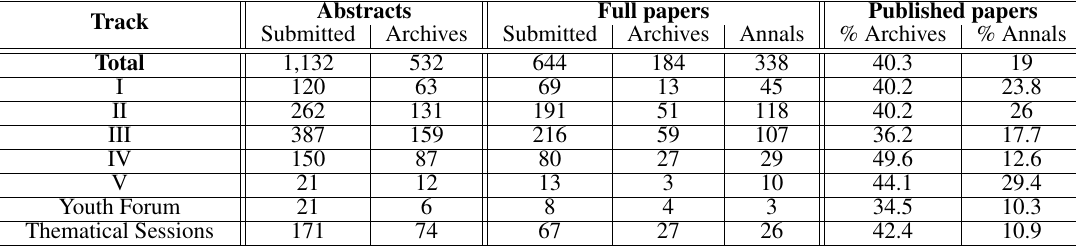
Table 2. Detailed statistics for each track.